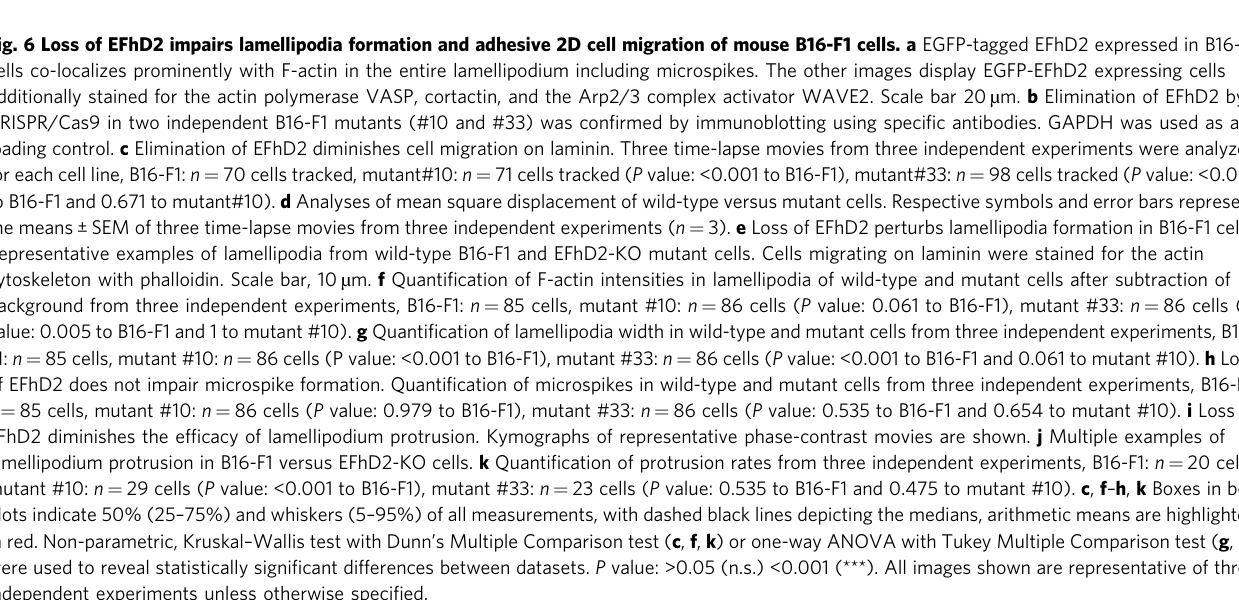
Swip-1 protein was con fi rmed by Western blot analysis stained against His-Swip-1 (Pineda, Berlin). Protein puri fi cation . Expression of GST-tagged human EFhD2, wild type, and mutant Swip-1 in Escherichia coli strain Rossetta 2 (Novagen) was induced with 0.75 mM IPTG at 21 °C for 16h. The bacteria were harvested and lysed by ultra- sonication in PBS, pH 7.4 containing 5 mM benzamidine, 1 mM DTT, 5% (v/v) glycerol, 0.1 mM AEBSF and 2units/mL Benzonase (Novagen). The fusion proteins were puri fi ed from supernatants of bacterial extracts by af fi nity chromatography using glutathione-conjugated agarose 4B (Macherey-Nagel). The GST-tag was subsequently cleaved off by PreScission protease (GE Healthcare) and the GST tag